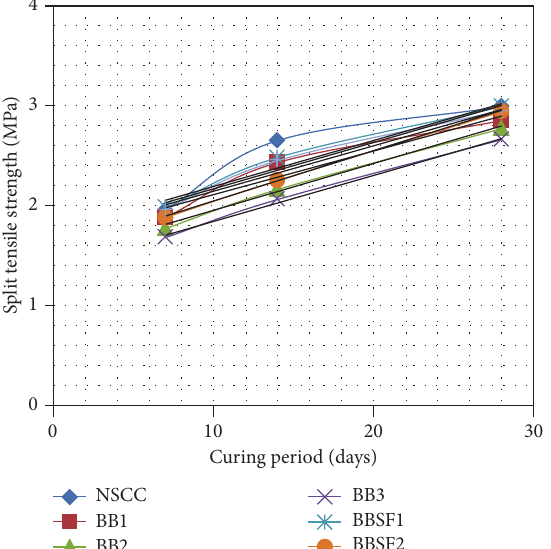
Figure 7: Comparison of the split tensile